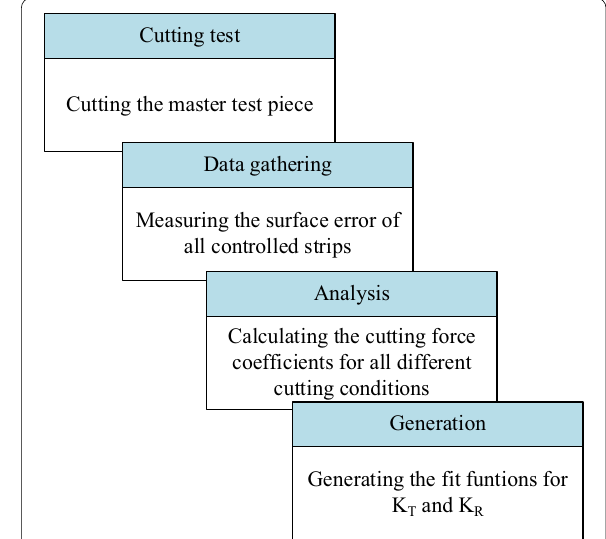
Figure 22 Process of identifying the cutting force